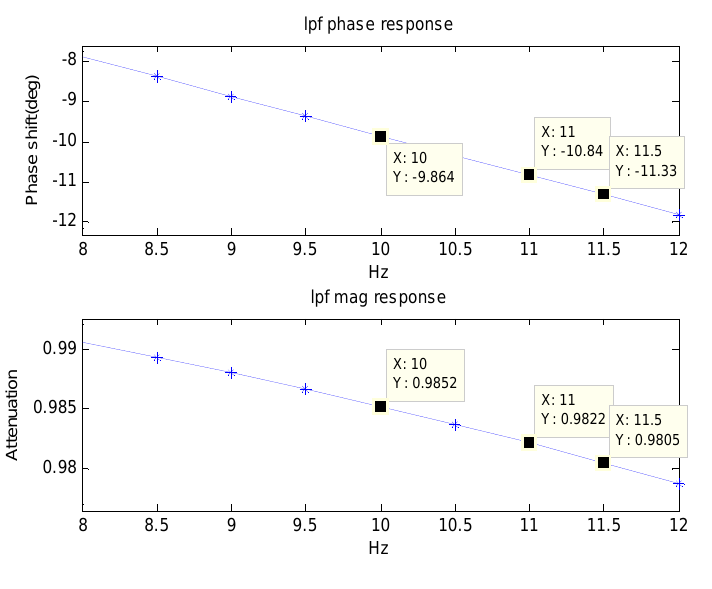
Figure 7. Frequency response of the first-order low-pass filter with a cutoff frequency of 50